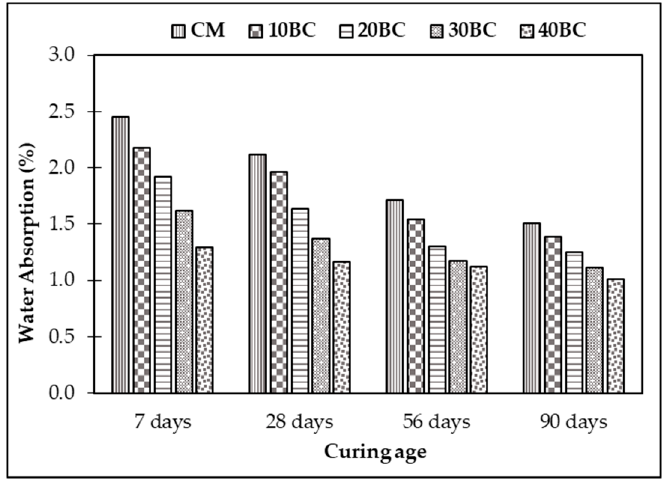
Figure 7. Water absorption (%).